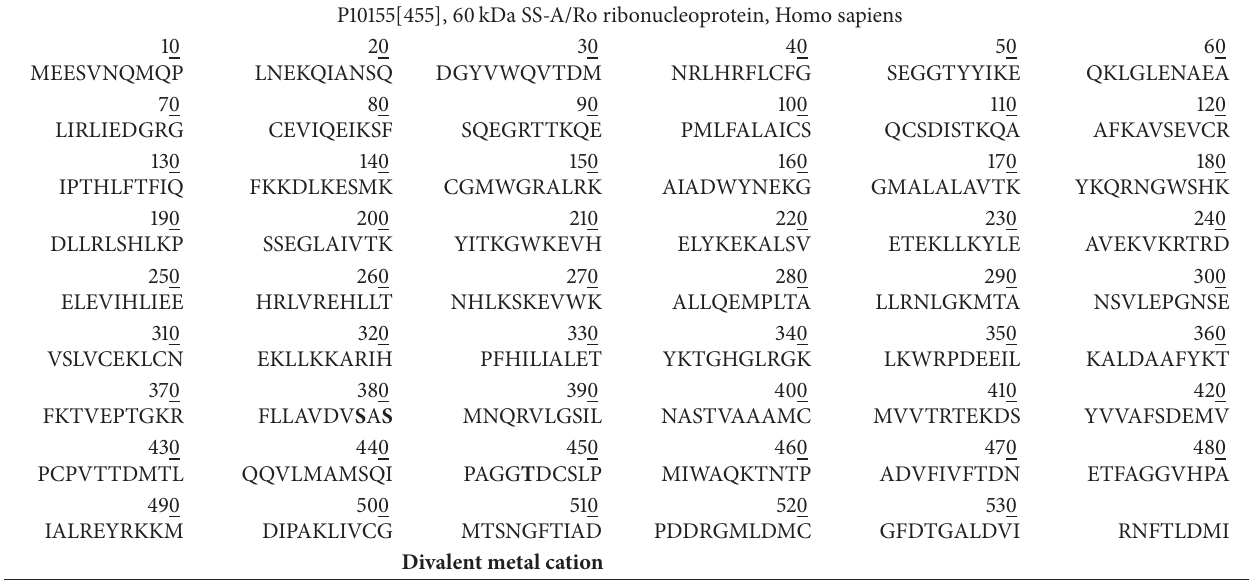
Table 2: Ro60 ribonucleoprotein analyzed using the NCBI graphical sequence viewer displaying the three metal-ion dependent adhesion sites (MIDAS) at positions 378, and 380 (serine), and 445 (threonine) (UniProtKB/Swiss-Prot: